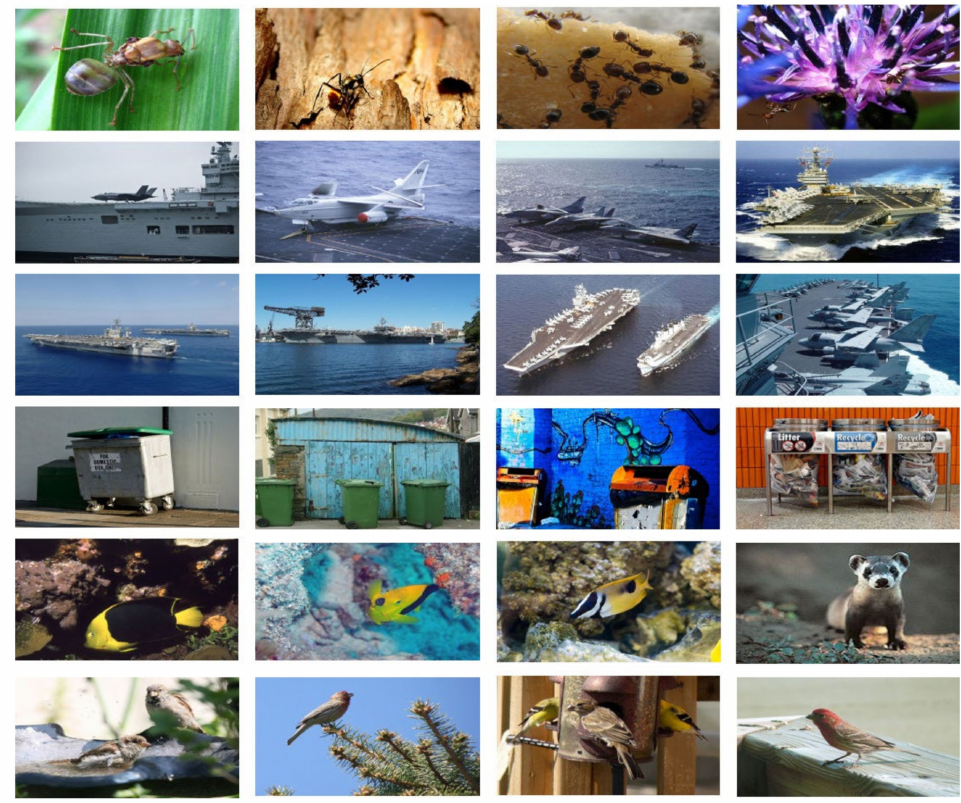
Figure 4. Part of the Miniimagenet dataset. The types of data, image structures, and shooting angles are greatly different from remote sensing